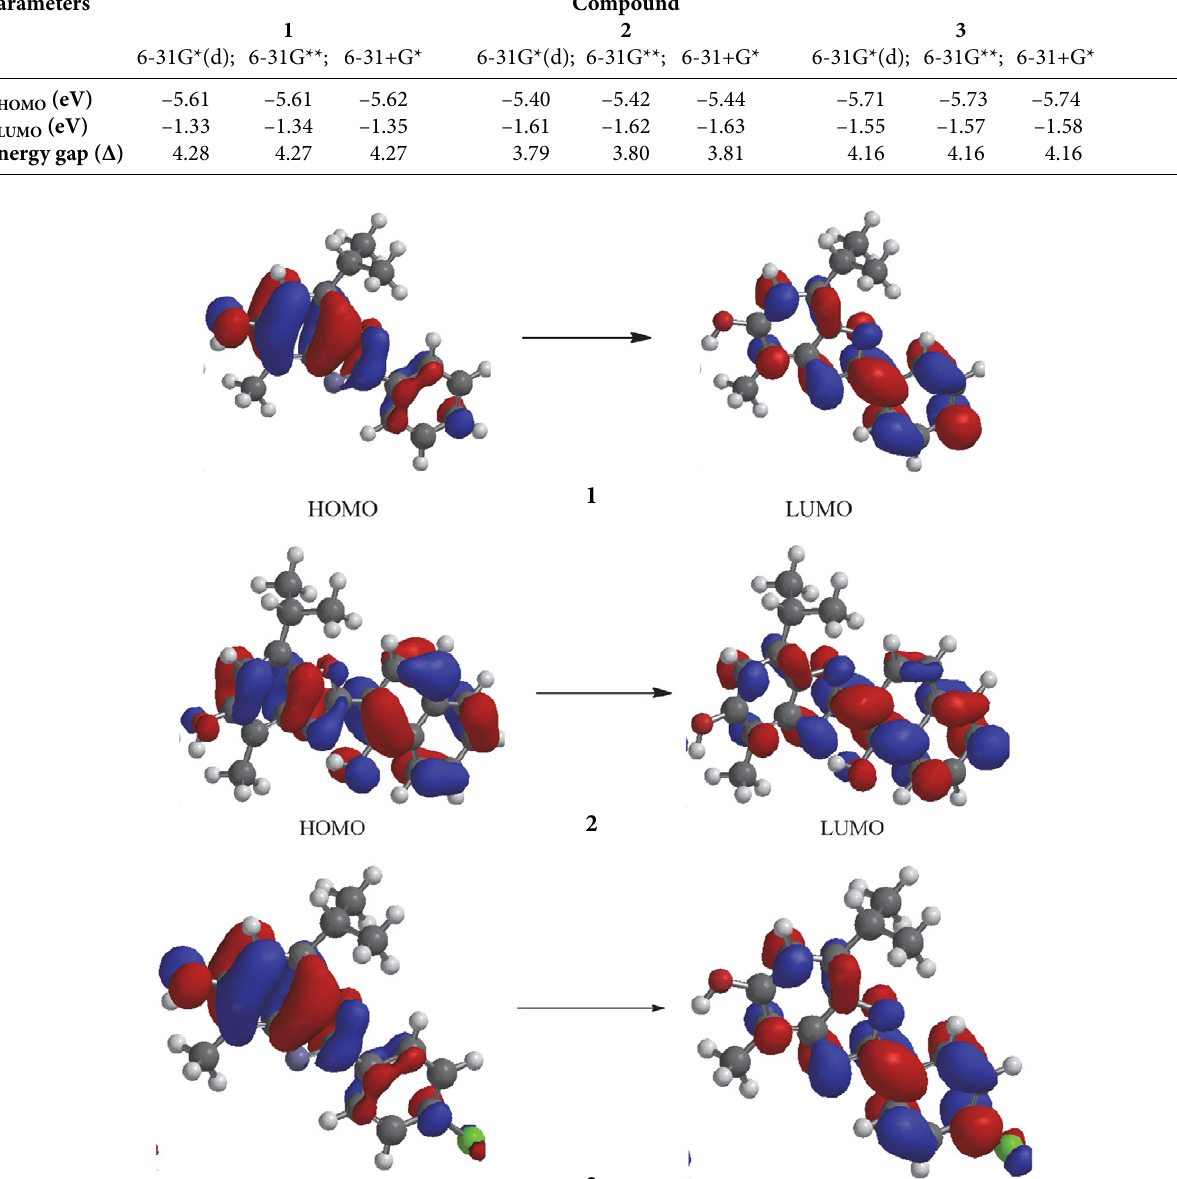
Table 4. Calculated HOMO and LUMO energy values in compounds 1 , 2 and 3 Parameters